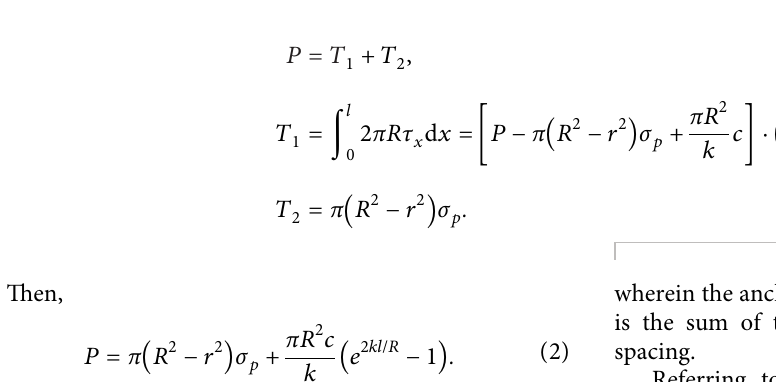
Figure 2: Force analysis of the polycystic aeration